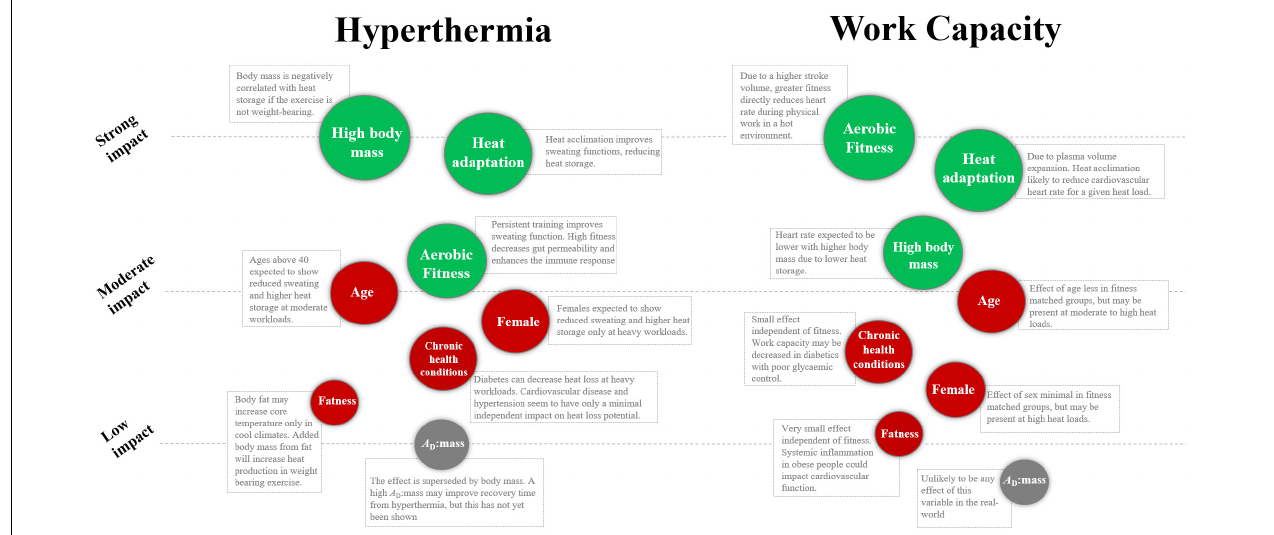
FIGURE 1 | Relative influence of individual characteristics on T c and work capacity during physical work in the heat. Green variables indicate a positive influence, red variables indicate a negative influence, and the gray variables are deemed not relevant. The orders are based on the authors’ interpretation of the literature, as explained in the clarification of terms section. A D :mass, surface area to mass